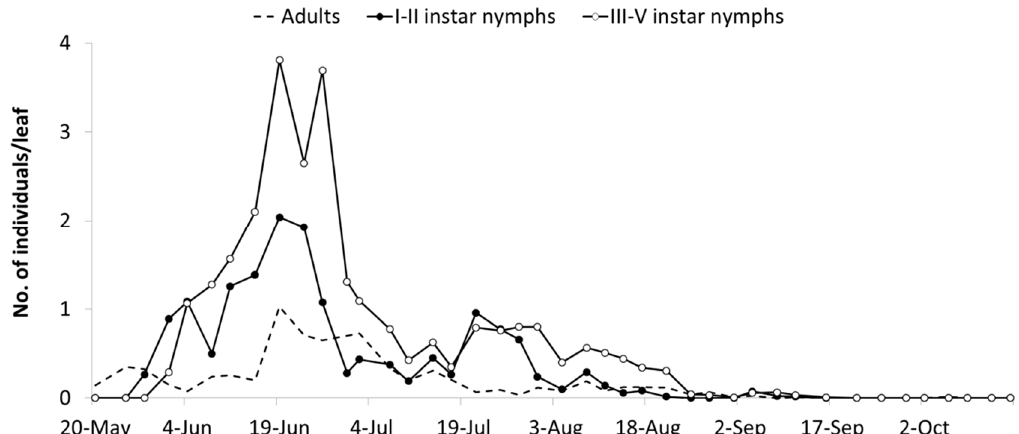
Figure 4. Seasonal abundance of Erasmoneura vulnerata nymphs and adults observed on leaves of potted plants placed close to rural buildings (A2 area, 2009).